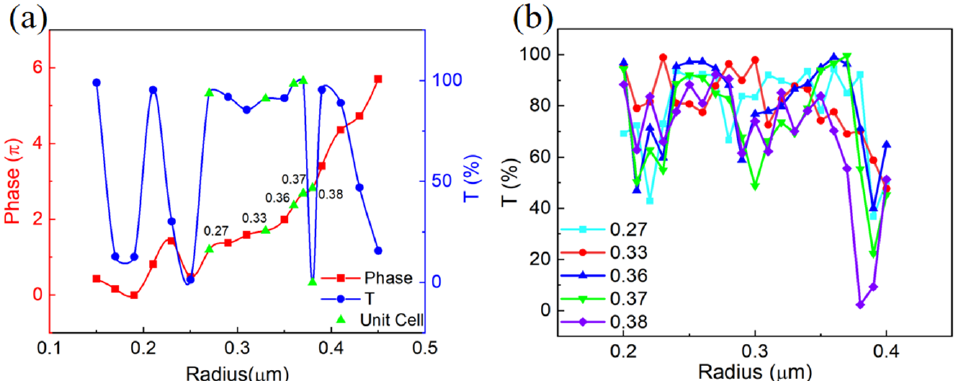
Figure 2. ( a ) The phase (red line) and transmittance curves (blue line) of outgoing light at 1.55 µ m wavelength when the nanocolumn radius changes from 0.15 µ m to 0.45 µ m. The radius dimension points of the selected metasurface unit cell structure are marked in green. ( b ) The transmittance curves corresponding to different distances of nanocolumns. technique method. The light source is a 1.55 µ m linearly polarized plane wave incident